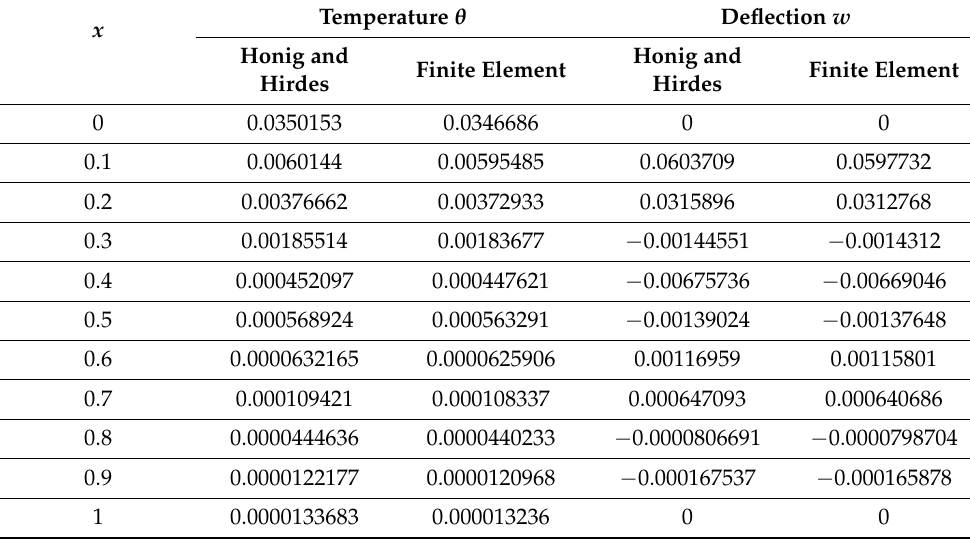
Table 1. Comparison between Honig and Hirdes technique and finite element